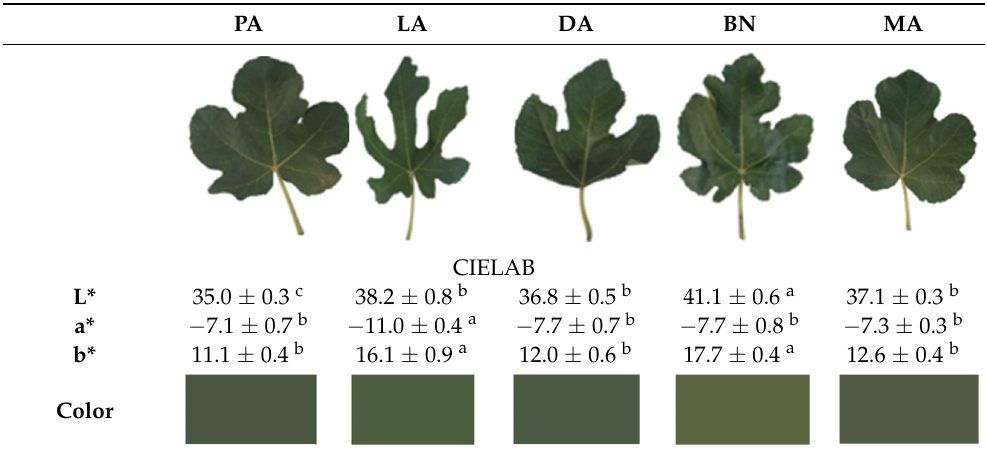
Table 1. Color analysis in fig leaves.